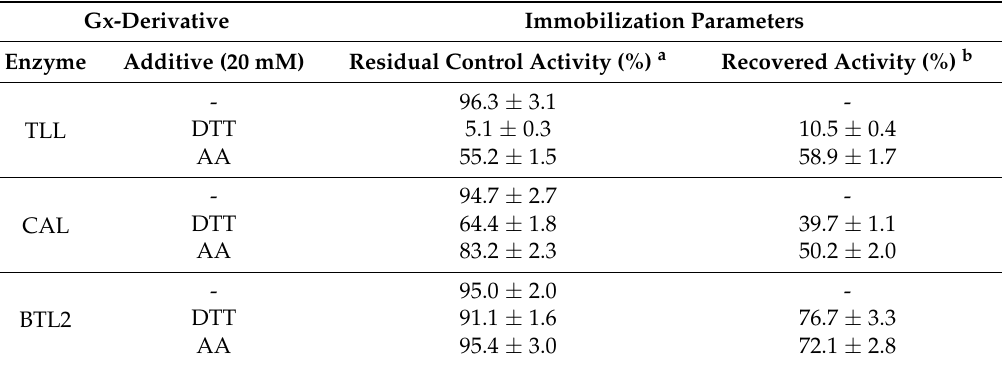
Table 2. Immobilization parameters of aminated lipases on Gx at neutral pH and 25 °C.